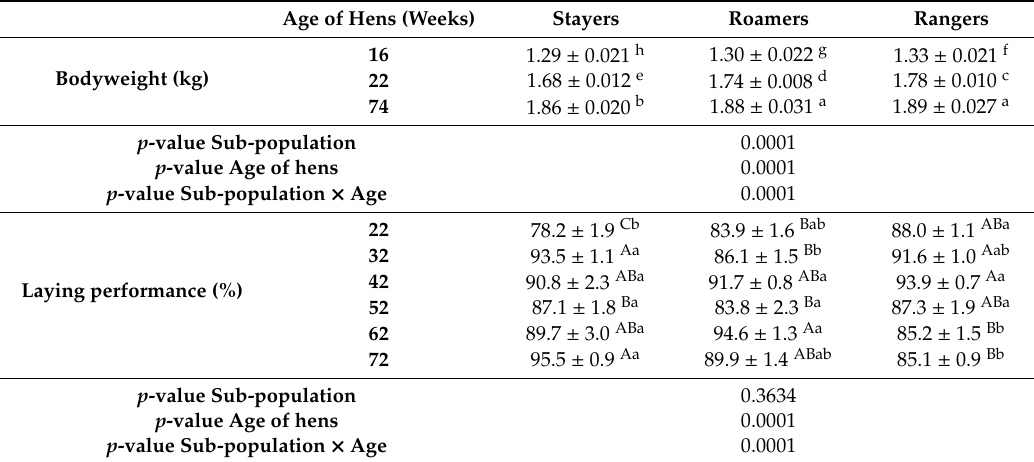
Table 1. Tukey post-hoc comparison of the di ff erences between stayers, roamers and rangers with respect to body weight and laying